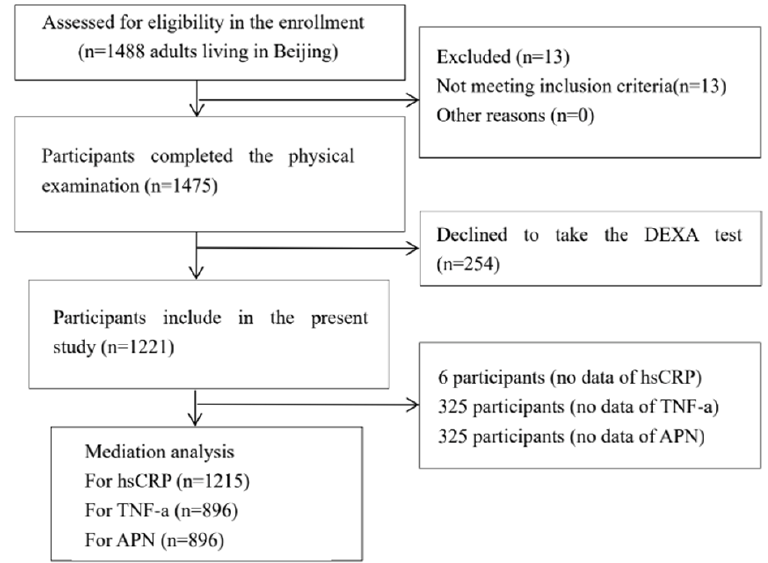
Figure 2. Flowchart of the study sample selection (dual-energy X-ray absorptiometry, DEXA; hsCRP, high sensitivity C-reactive protein; TNF- α , tumor necrosis factor- α ; APN, adiponectin; FLD, Fatty liver disease).